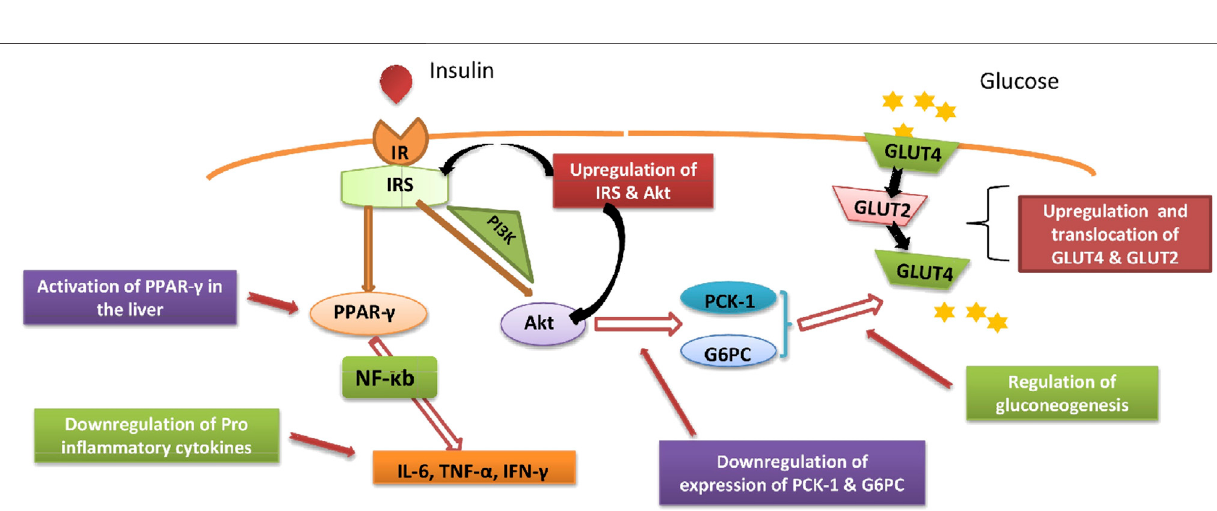
Frontiers in Pharmacology |